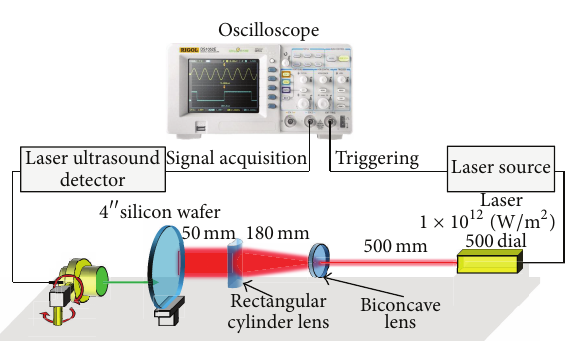
Figure 4: Experimental